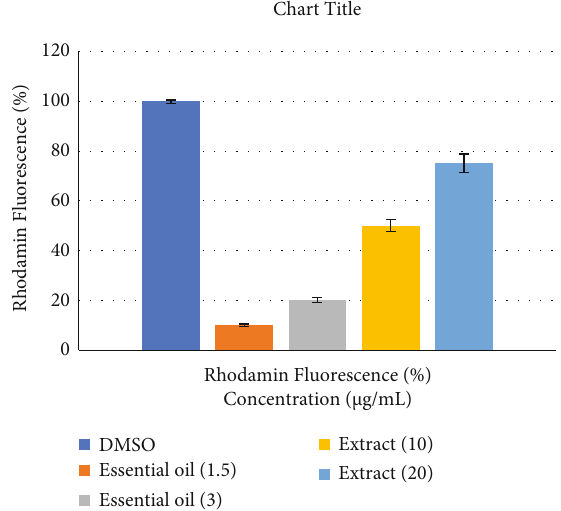
Figure 4: E ff ect of aqueous extract and essential oil of D. ammoniacum oleo-gum resin on MMP in A549 cells detected with Rh123 via fl uorescence microplate reader. The results are expressed as mean ± SD of three independent experiments ( n = 3 ). Turkey-Kramer test was used to examine the statistical di ff erence.